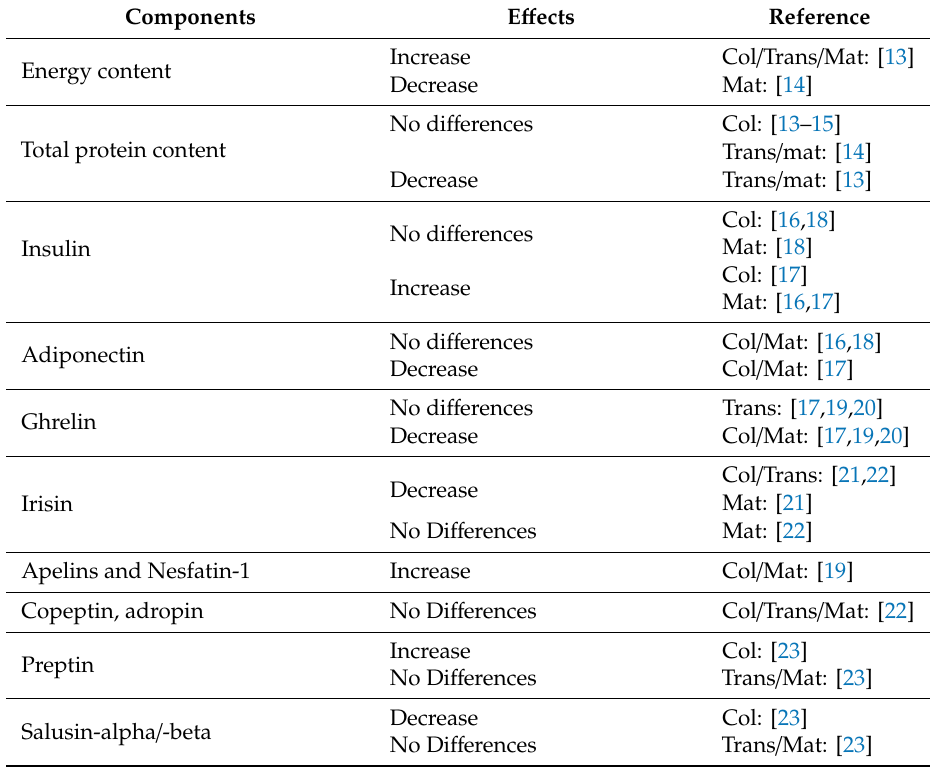
Table 2. Results of the di ff erent studies included in the survey regarding GDM and